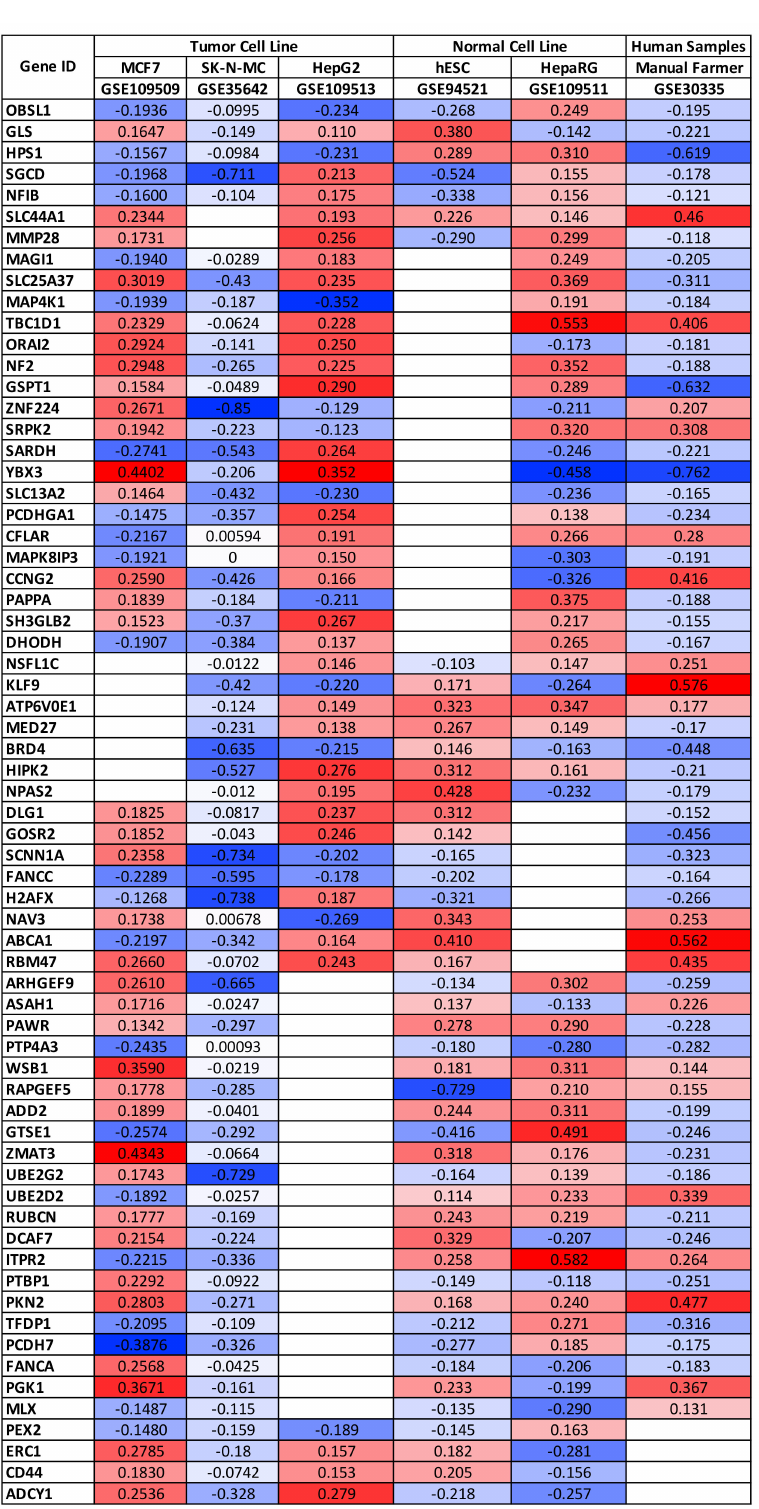
Figure 1. Differentially expressed genes after pesticide exposure in human samples and in vitro models. The fold change values are expressed as log2 of fold change. Up-regulated genes are highlighted with red scale boxes while down-regulated genes are highlighted with blue scale